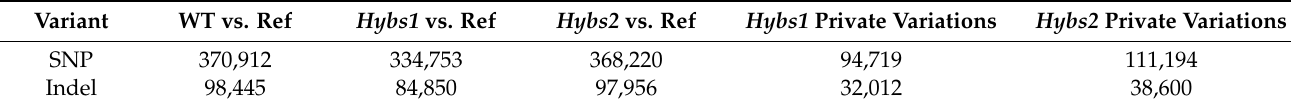
Table 1. Number of SNPs and Indels Identified in WT, hybs1 , and hybs2 . Variant WT vs. Ref Hybs1 vs. Ref